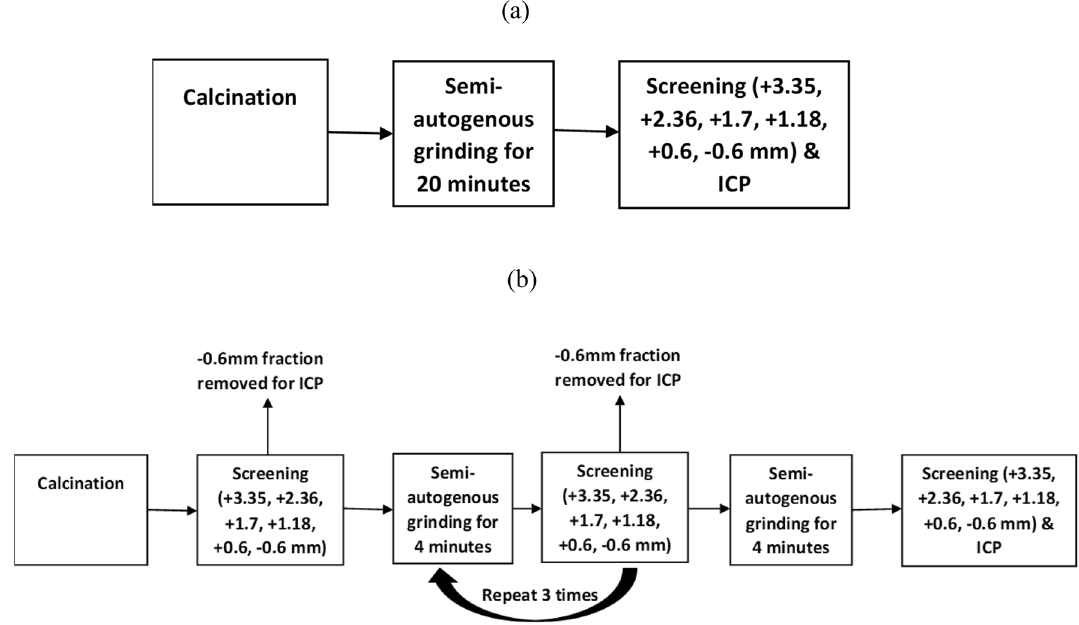
Figure 2. Development flowchart ( a ) the open-circuit grinding and ( b ) the closed-circuit had 12 grinding balls (each grinding ball had 27.3 mm in diameter) with a total mass of 1060 g; the rotational speed of the mill was 70 rpm. The grinding product was screened into six different size fractions (+ 3.35 mm, − 3. 35 + 2.36 mm, − 2.36 + 1.7 mm, − 1.7 + 1.18 mm, − 1.18 + 0.6 mm, − 0.6 mm) to study the particle size distribution (PSD) and the lithium grade in the finest fraction (− 0.6 mm). Considering that the ball mill had a low-ball mill loading (10%) in contrast to standard ball milling (50%), the ball mill was used to simulate a semi-autogenous grinding mill. feed. This sample was ground using the closed-circuit grinding in the same ball mill used for the open-circuit grinding to compare this mode of grinding with the open-circuit grinding. tions: − 0.6 mm (the fine fraction) and + 0.6 mm (the coarse fraction). The fine fraction was not ground again to prevent overgrinding of the feed and thus reduce energy during grinding. The coarse fraction was ground after each grinding stage. The coarse fraction was screened into five different size fractions (+ 3.35 mm, − 3.35 + 2.36 mm, − 2.36 + 1.7 mm, − 1.7 + 1.18 mm, − 1.18 + 0.6 mm) to study the PSD (particle size distribution) after each grinding stage. The chemical analysis was conducted through digestion of the solids, and ICP-OES (Agilent Technologies 5100) was used to determine the lithium content in the fine size fraction (− 0.6 mm). The standard